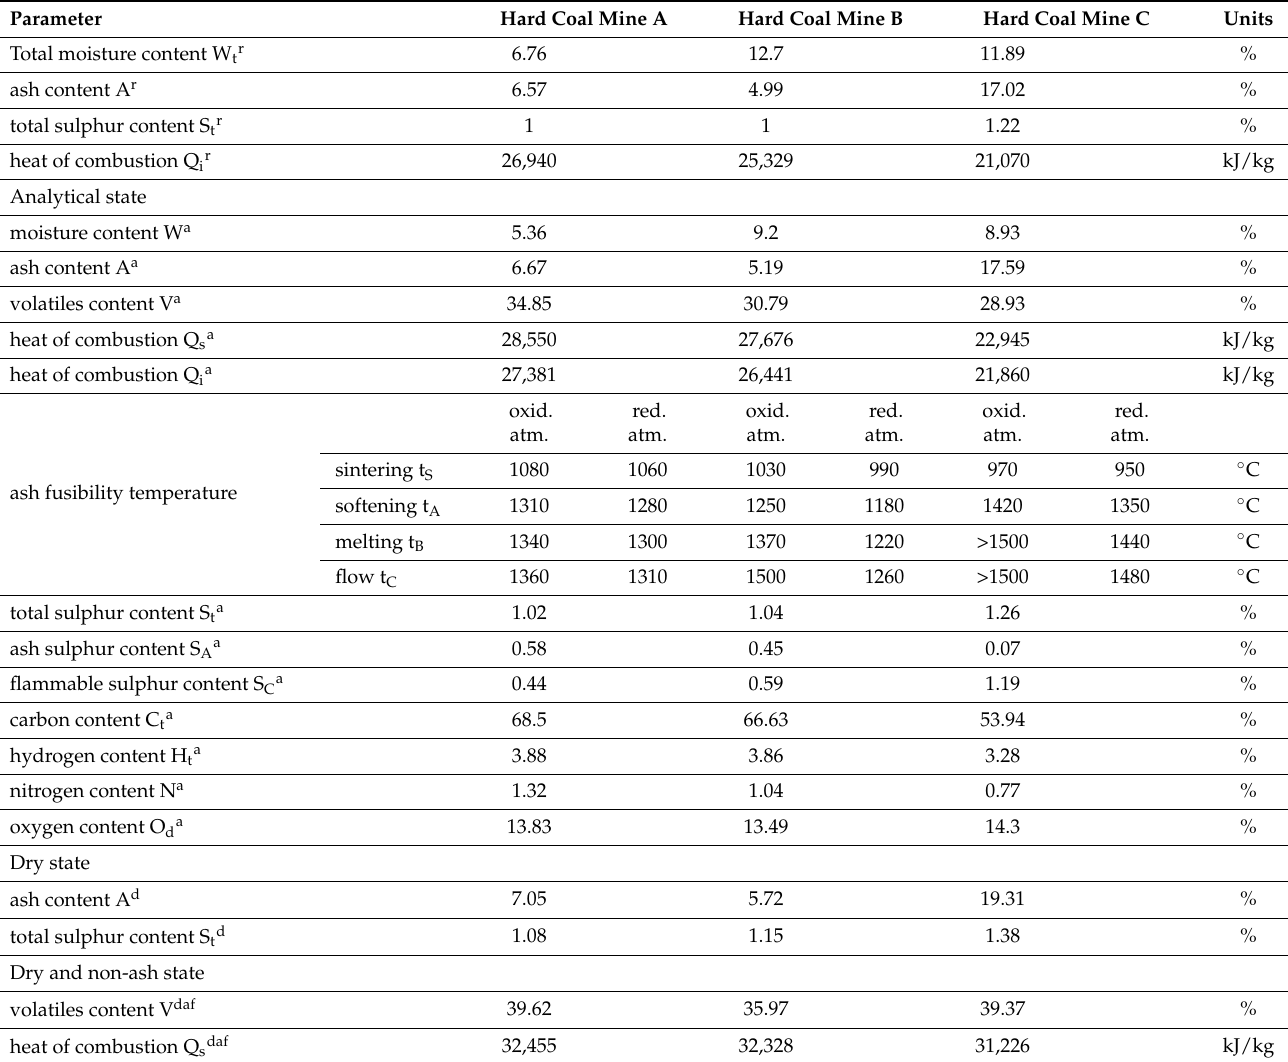
Table 1. Proximate/ultimate analysis of the coal seam from hard coal mine A, B, C. Hard Coal Mine A Hard Coal Mine B Hard Coal Mine